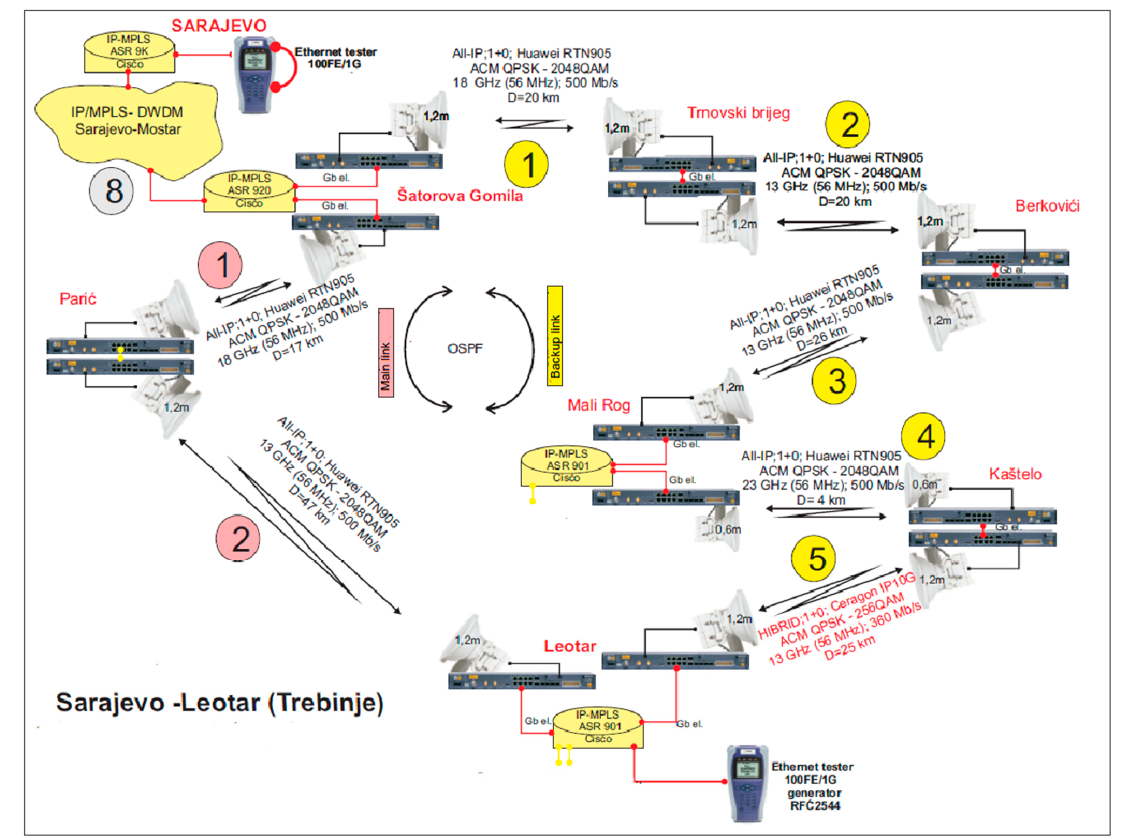
Figure 17. End-to-end Ethernet testing on the RR system under test.